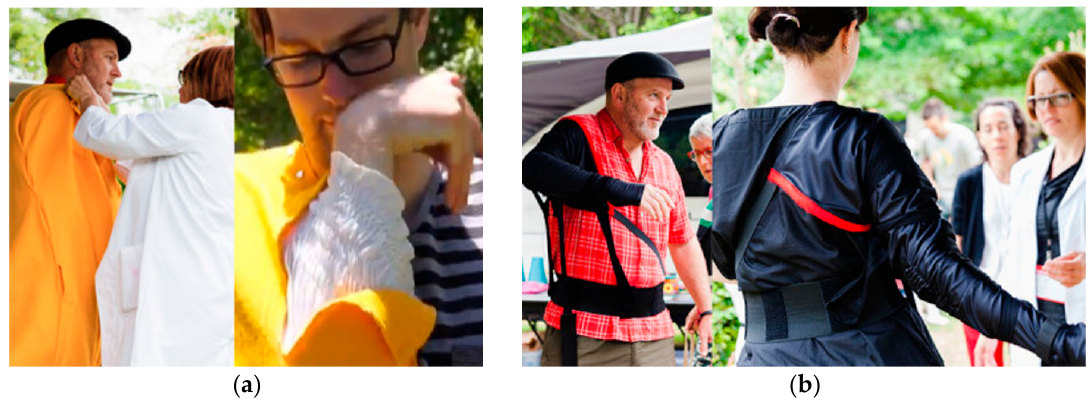
Figure 3. Loom 1 probe-set (3): Sleeves: ( a ) Yellow Sleeve , ( b ) Red & Black Sleeve.